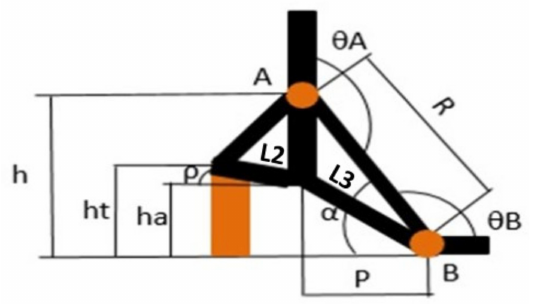
Figure 1. Simplification of the foot–ankle set on the sagittal plane with increasing heel height. A: tibiotalar joint location: B: metatarsophalangeal joint location; θ A: tibiotalar joint angle of rotation; θ B: metatarsophalangeal joint angle of rotation; R: linear distance between both joints; h: height of the an- kle joint; ht : heel height; ha: seating heel height; ρ : tilt angle of the seating heel; α : rotation angle at